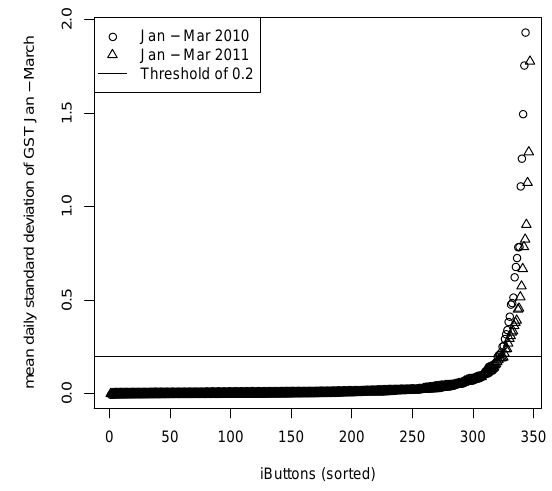
Fig. 2. Mean daily standard deviation of GST from January to March. The horizontal line indicates the threshold of 0.2. The obvious knee in the curve represents the separation between an insulating- and a non-insulating snow cover with one threshold. The sensitivity to the chosen threshold is relatively low, as shown by a change in the applied threshold of 50% causes a change in the se- lected sample size of less than